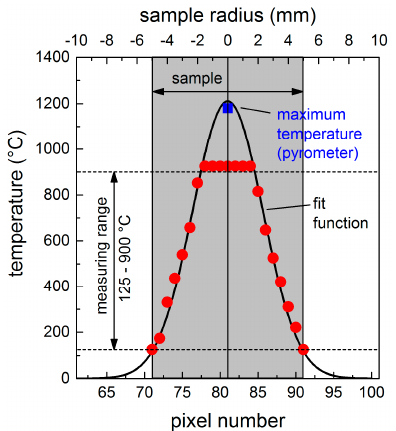
Figure 2. Experimentally measured local substrate temperatures (colored dots) and interpolated temperature profile T S ( r ) (black solid line) during cw CO 2 laser irradiation. temperature profile T S ( r ) (black solid line) during cw CO 2 laser